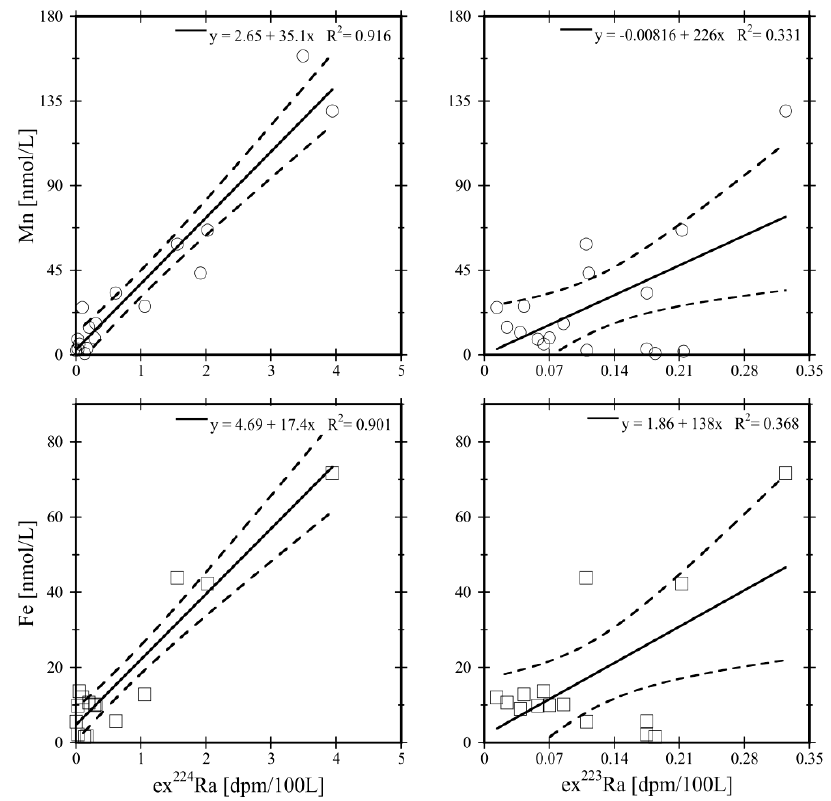
Figure 5. Linear correlations of ex 224 Ra and ex 223 Ra activities with dissolved Mn and Fe within the plume of Brothers volcano. The dashed lines indicate the 95-percent confidence interval.